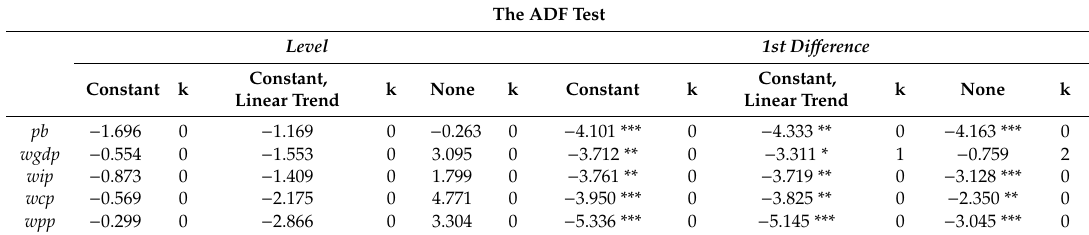
Table A8. W. The Unit Root test